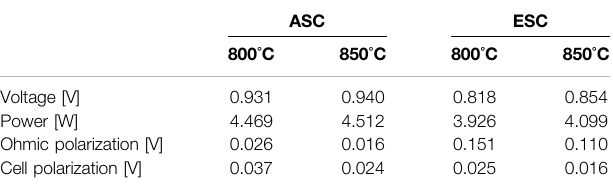
TABLE4| Comparisonofelectrochemicalperformanceat0.3 A cm − 2